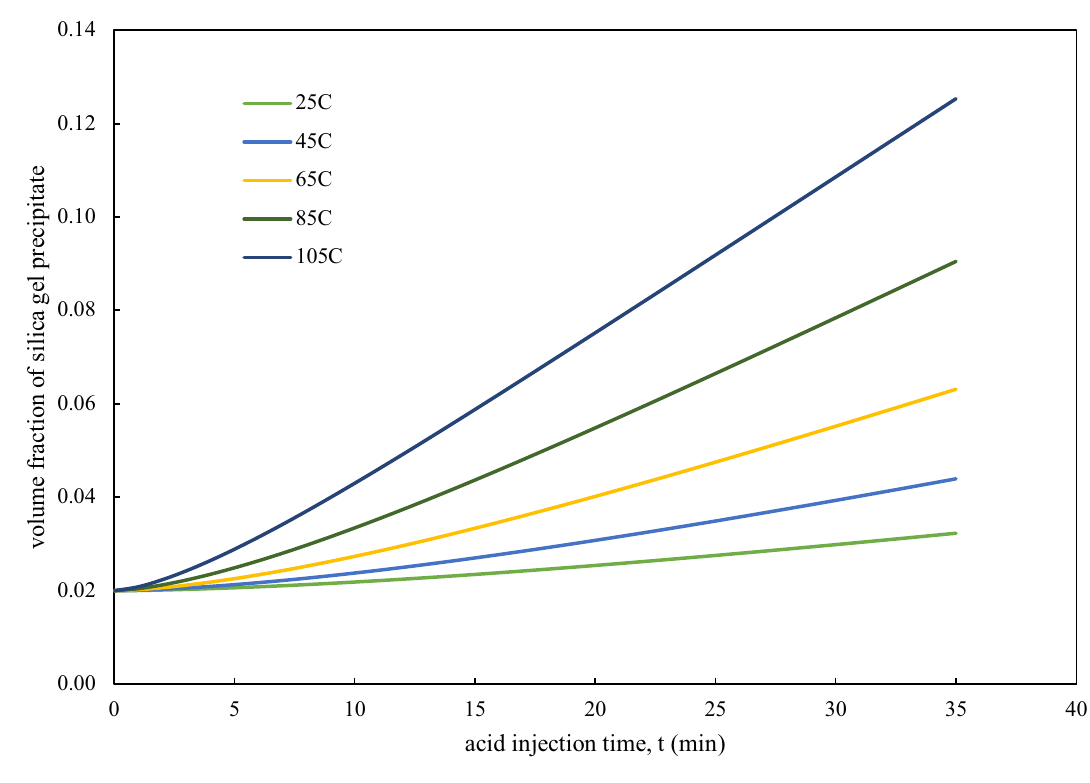
Fig. 20 The effect of temperatures on silica gel precipitate composition over injection